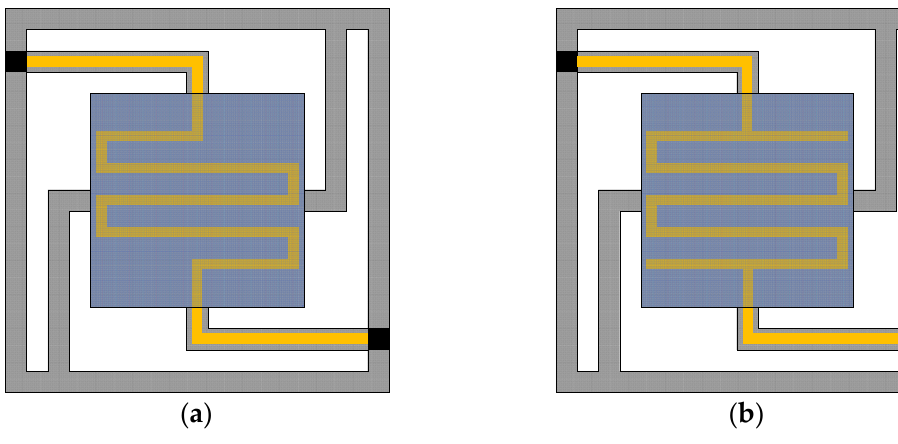
Figure 5. Tow ECLC models. ( a ) I-ECLC model; ( b ) II-ECLC model.